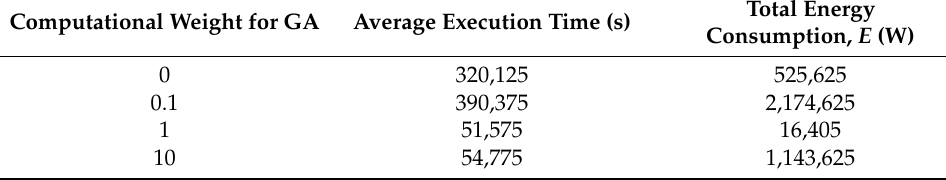
Table 1. Computational results for the GA method under various weights.